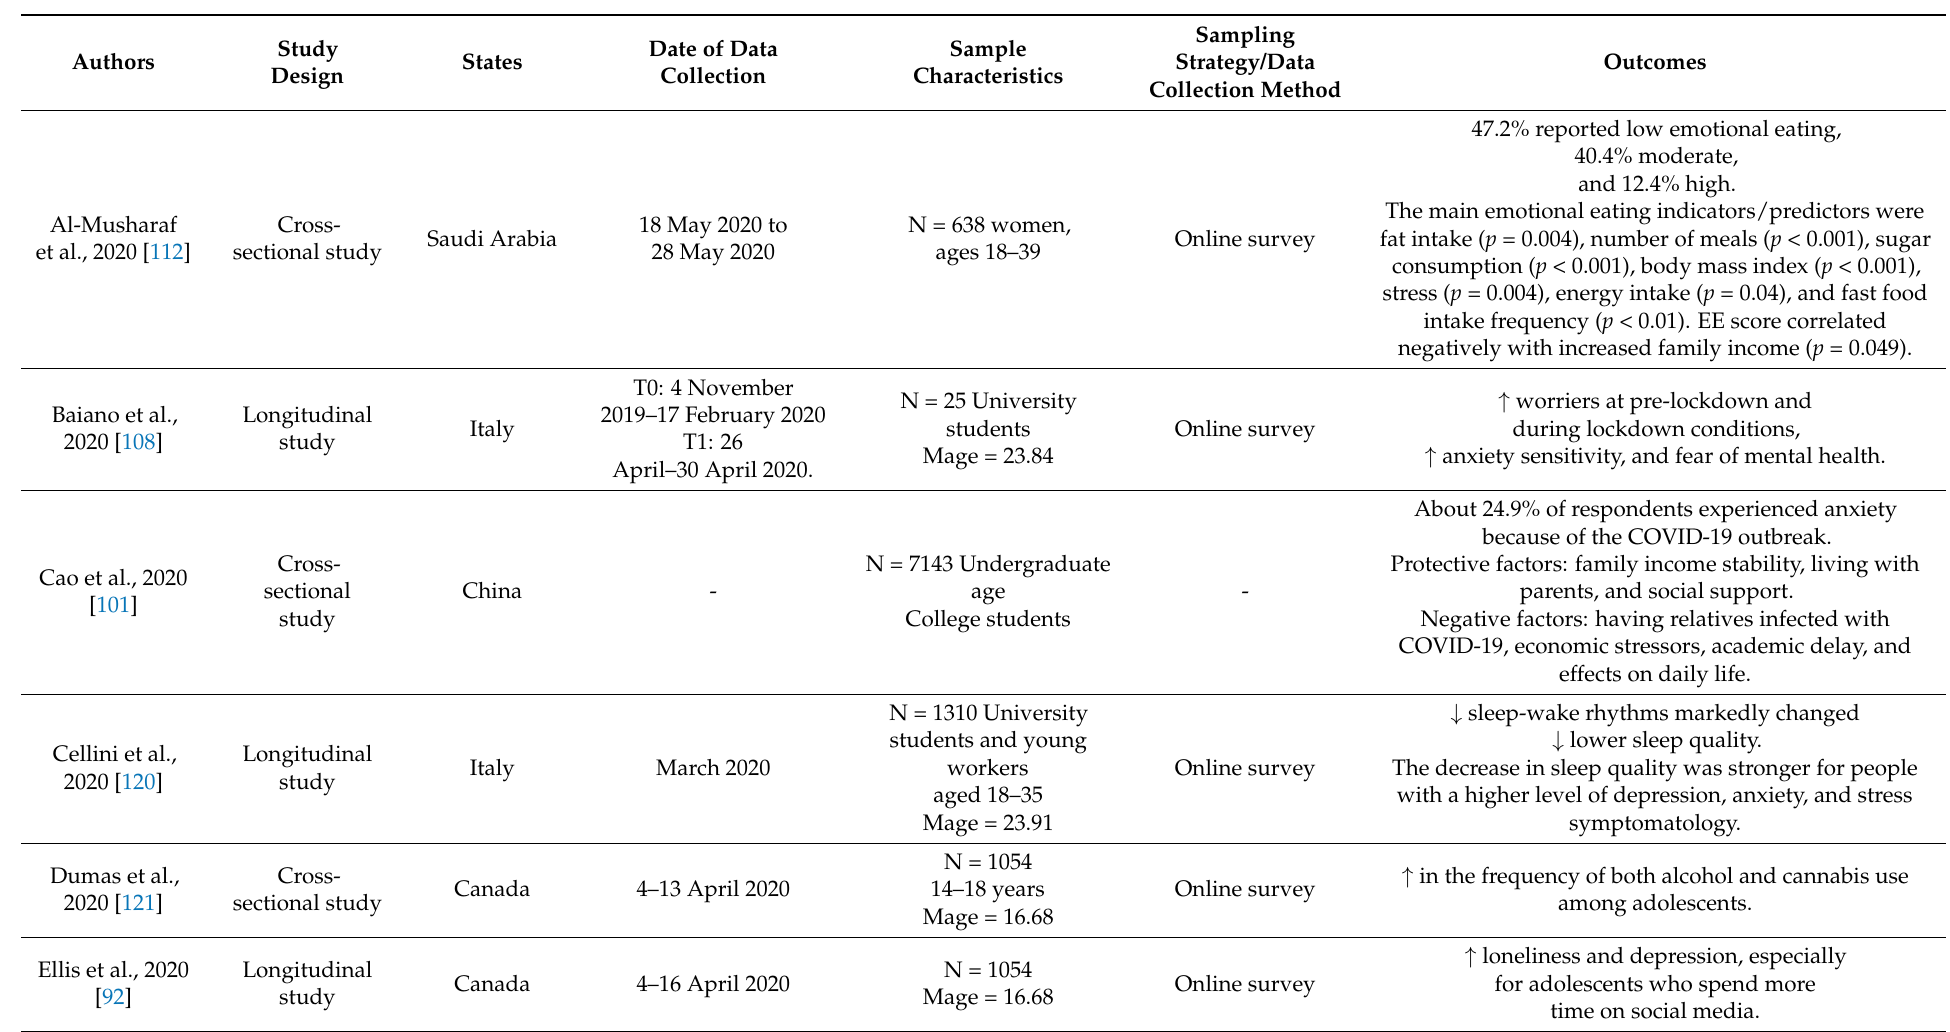
Table 2. Onset of new mental disorders and impact on pre-existing psychiatric